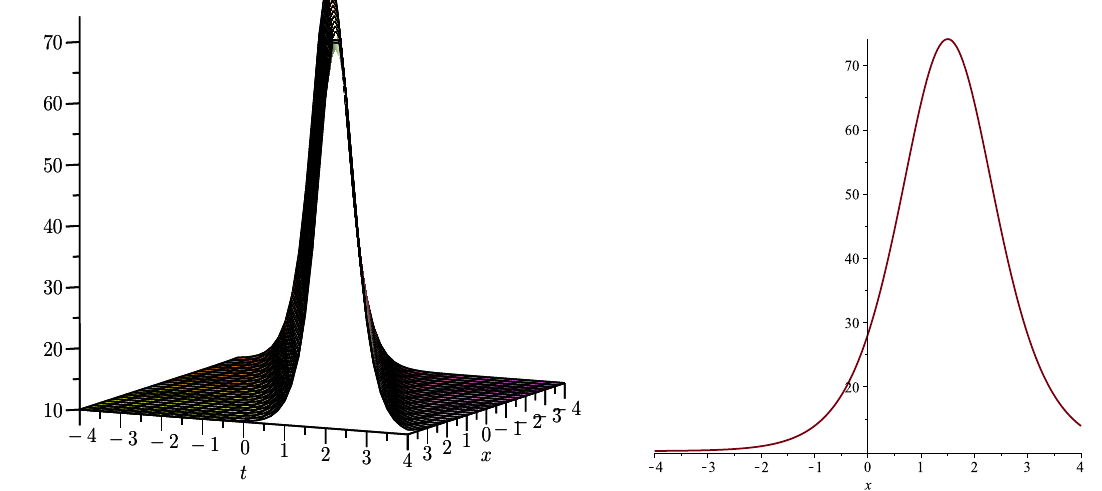
x , t 4 4. ( right ) 2D − ≤ ≤